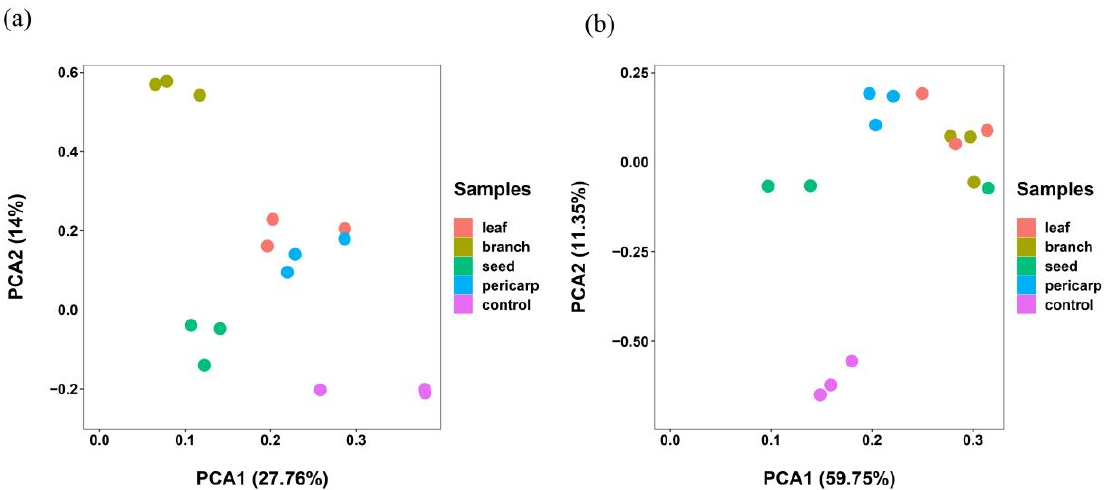
Figure 6. The principal component analysis (PCA) analysis was based on the operational taxonomic unit (OTU) (97% similarity clusters) abundance for soil fungi ( a ) and soil bacteria ( b ). The horizontal and vertical axes represent the two eigenvalues that can reflect the variance to the greatest extent. Each point in the figure represents a sample, the same color indicates the same group, and similar samples converge.